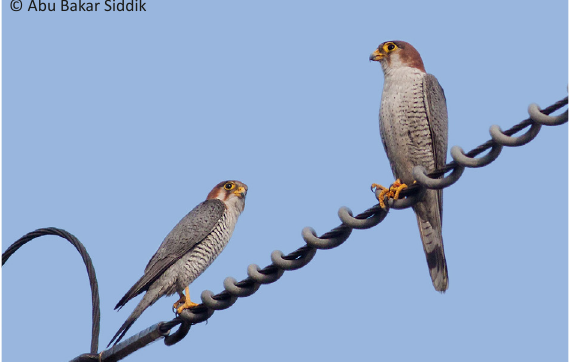
Image 1. Red-headed Falcon Falco chicquera - pair resting on electric cable